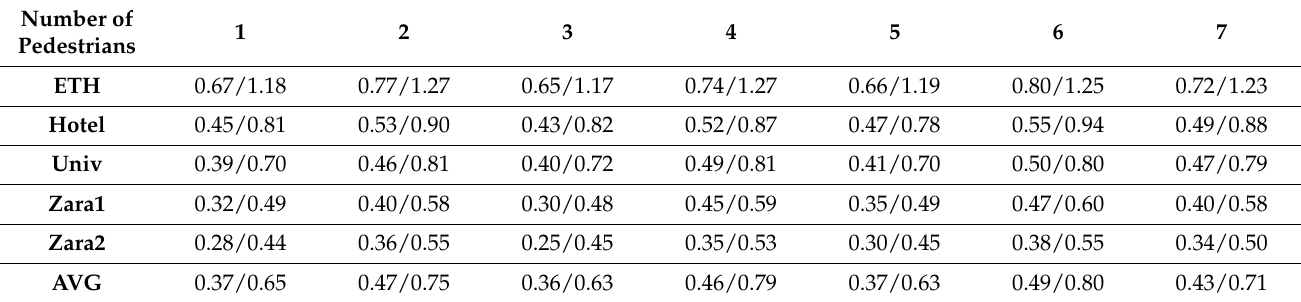
Table 4. The results of different pedestrian numbers obtained through ablation experiments.